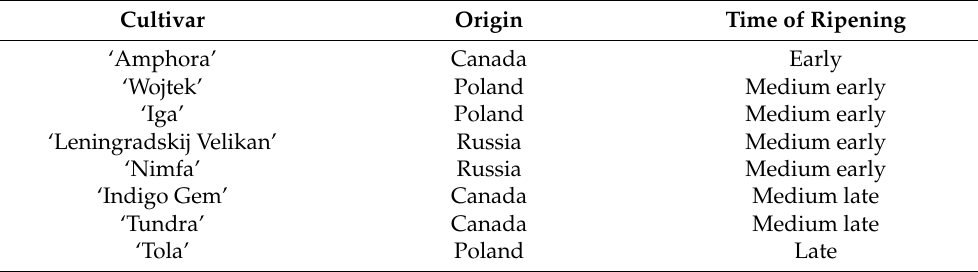
Table 1. Cultivar origin and ripening